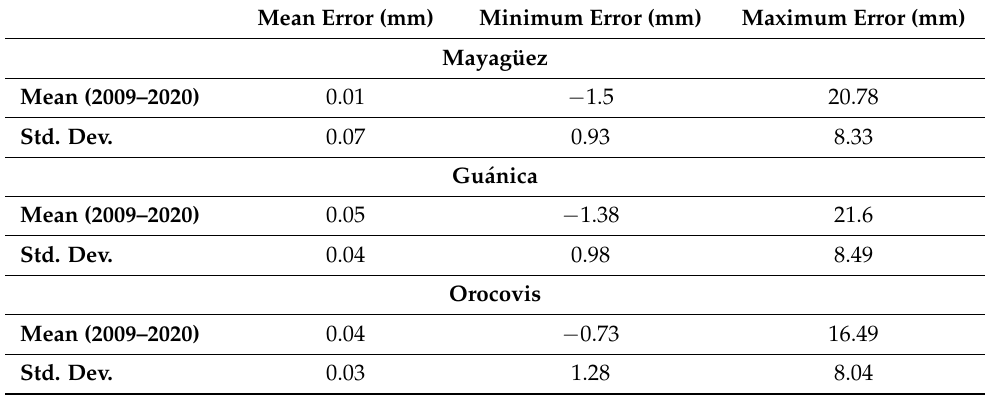
Table 6. Annual overall mean, minimum and maximum water balance errors for Mayaguez, Gu á nica and Orocovis for 2009–2020. All values are in millimeters.